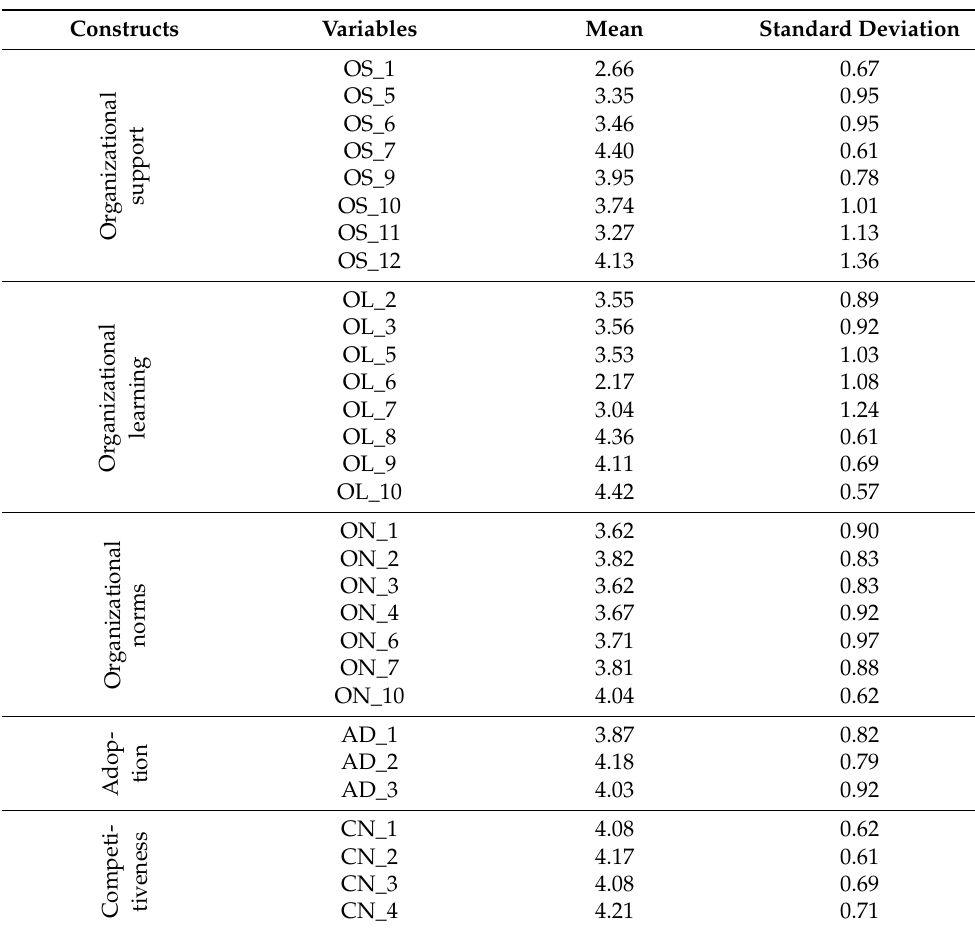
Table 1. Descriptive statistics of key